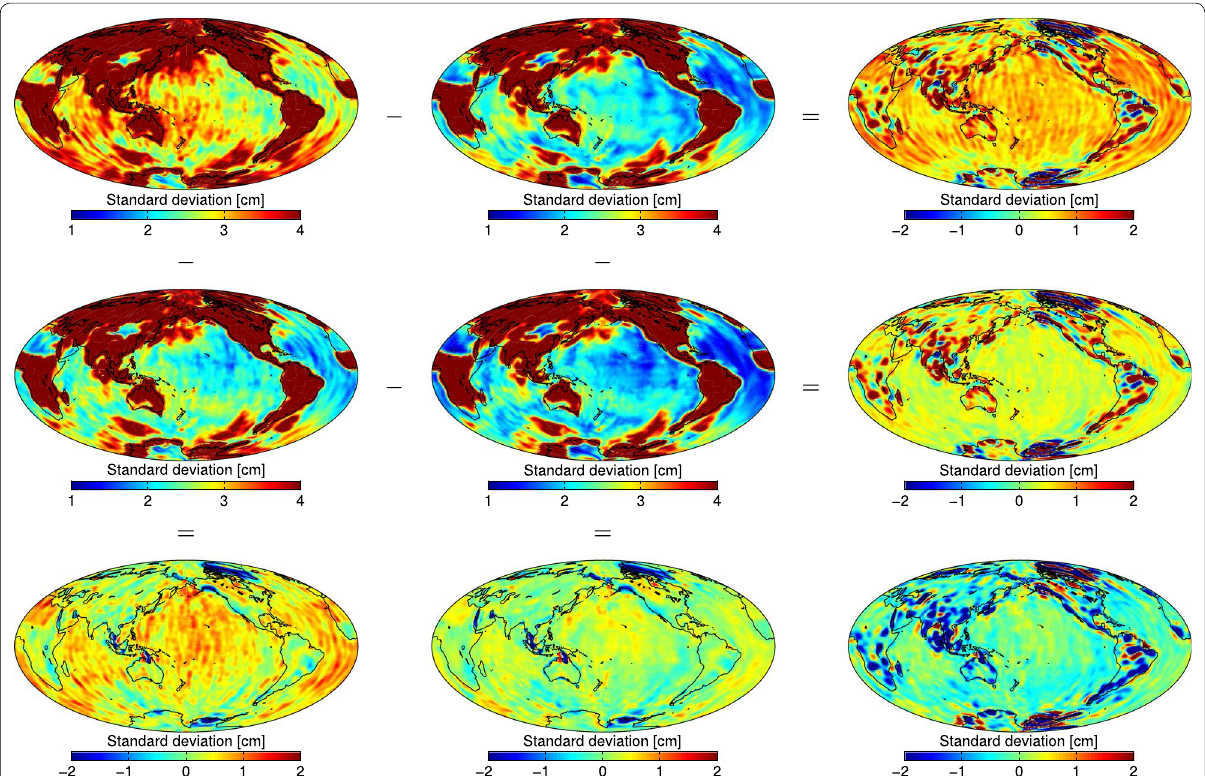
Fig. 2 Standard deviations of equivalent water heights over 13 years (2003–2015) derived from different GRACE gravity field solutions by applying different versions of the DDK filter: CSR RL05 DDK3 (top, left), CSR RL05 DDK2 (top middle), CSR RL06 DDK3 (middle, left), CSR RL06 DDK2 (middle, middle). Furthermore the following differences are shown: CSR RL05 DDK3–CSR RL05 DDK2 (top, right), CSR RL06 DDK3–CSR RL06 DDK2